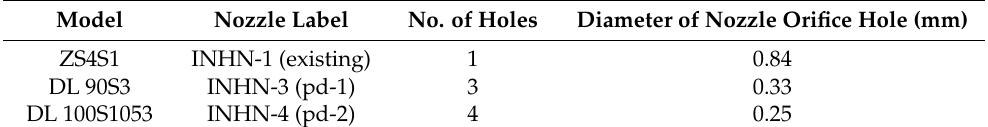
Table 5. Details of the injector nozzles.